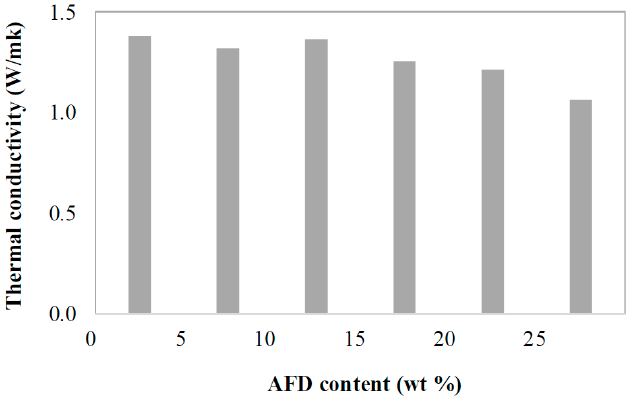
Figure 9. Estimated thermal conductivity of fired bricks as a function of AFD waste content.